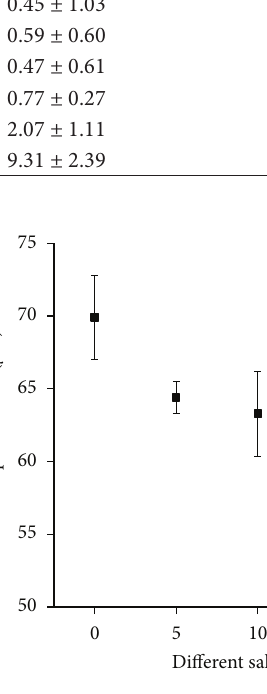
Figure 2: The variation of total membrane resistance at different salinity.